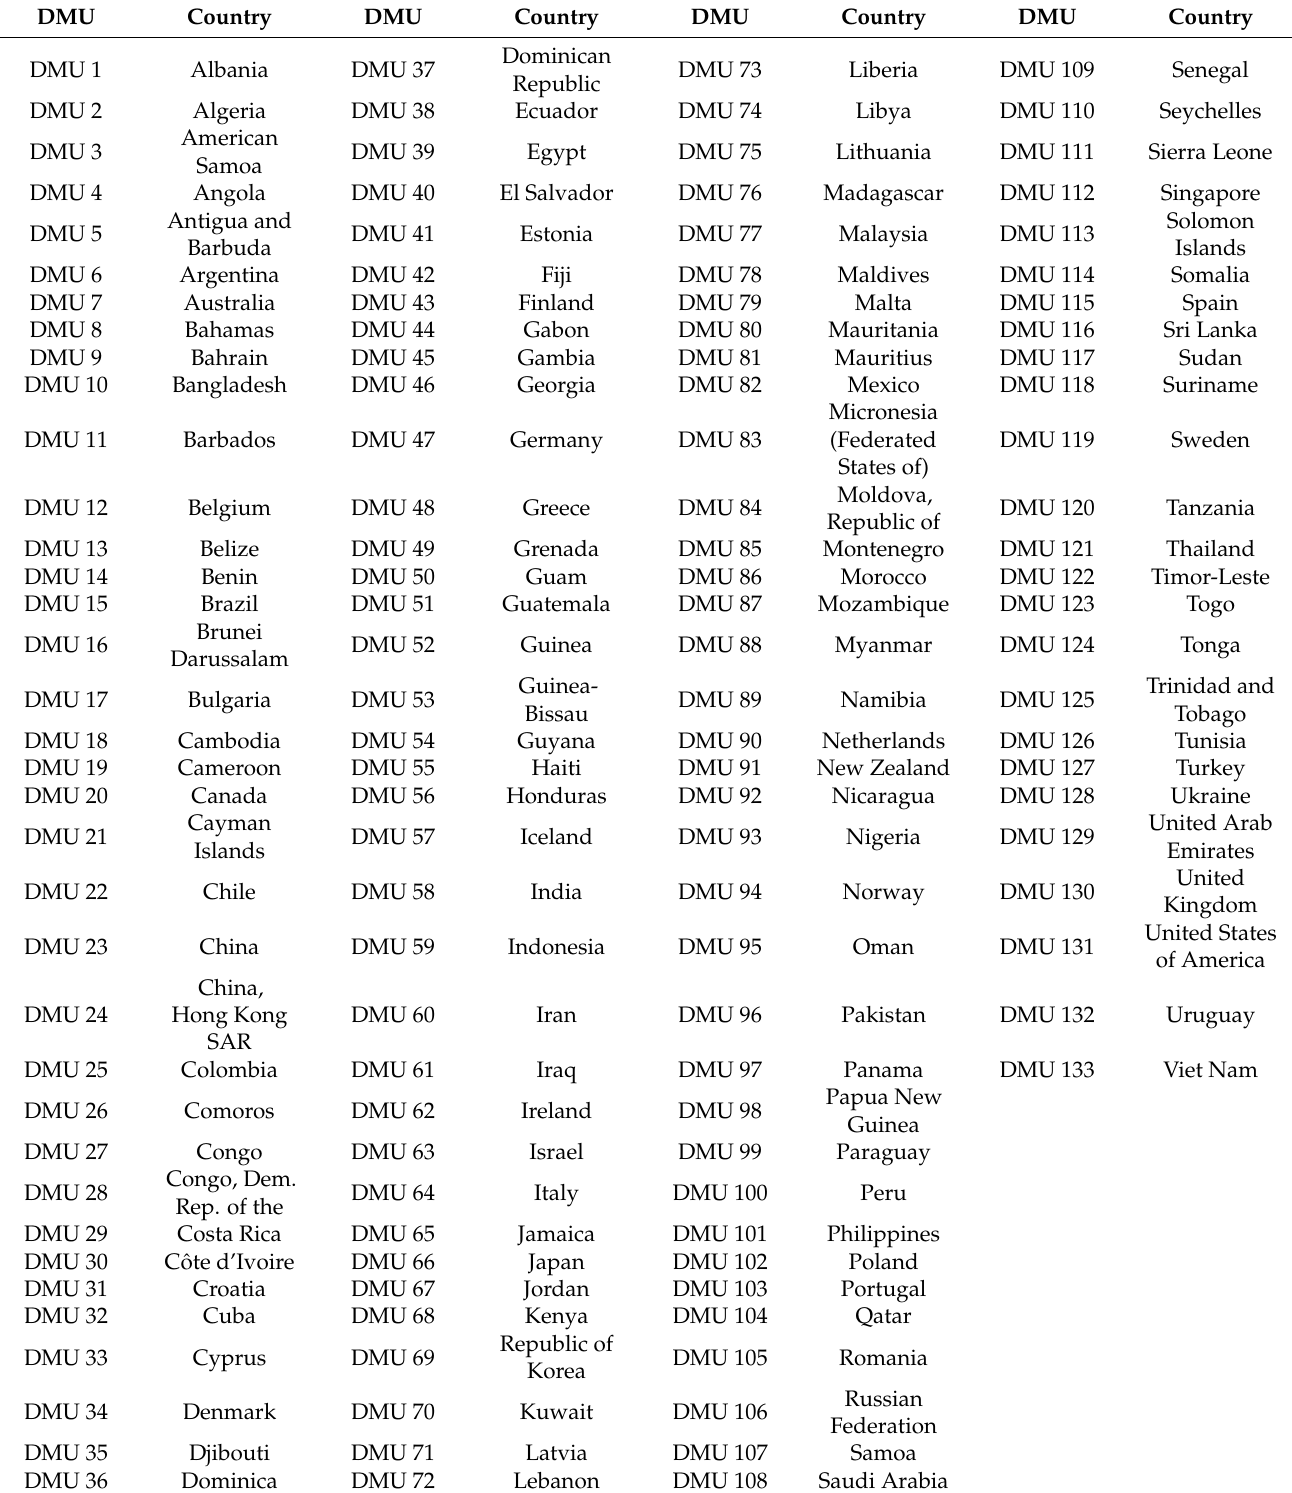
Table 1. List of DMUs applied in DEA and fuzzy DEA (TrFDEA and